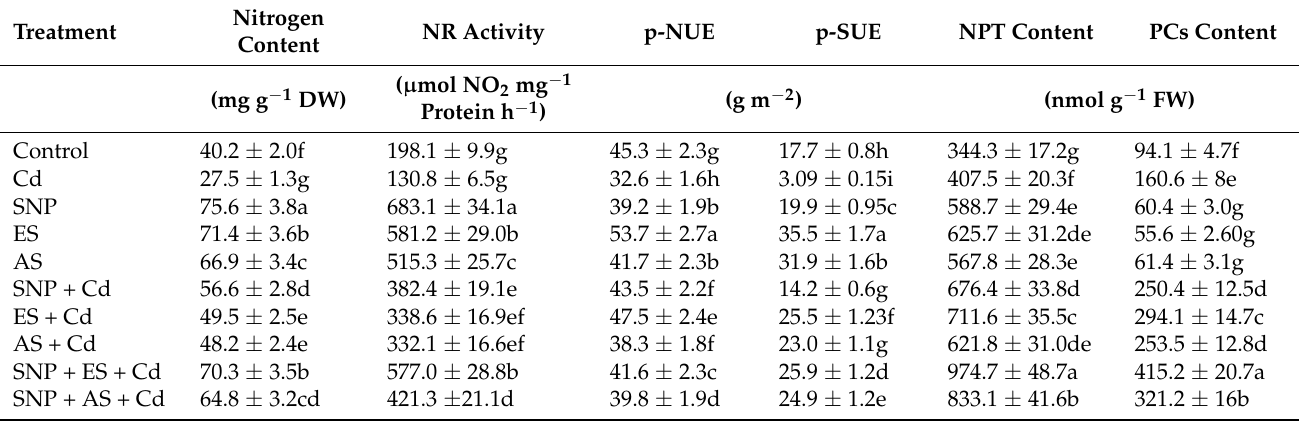
Table 5. Effect of 100 µ M SNP (NO donor) and 200 mg S kg − 1 soil of elemental sulfur (ES) or ammonium sulfate (AS) in the presence or absence of 200 mg Cd kg − 1 soil on nitrogen content, NR activity, photosynthetic-NUE, photosynthetic-SUE, NPT content, and PC content in mustard ( Brassica juncea L. cv. Giriraj). Data are presented as treatment mean ± SE ( n = 4). Data followed by the same letter are not significantly different as determined by LSD test at p ≤ 0.05. Cd, cadmium; DW, dry weight; FW, fresh weight; NR, nitrate reductase; NPT, non-protein thiol; NUE, nitrogen use